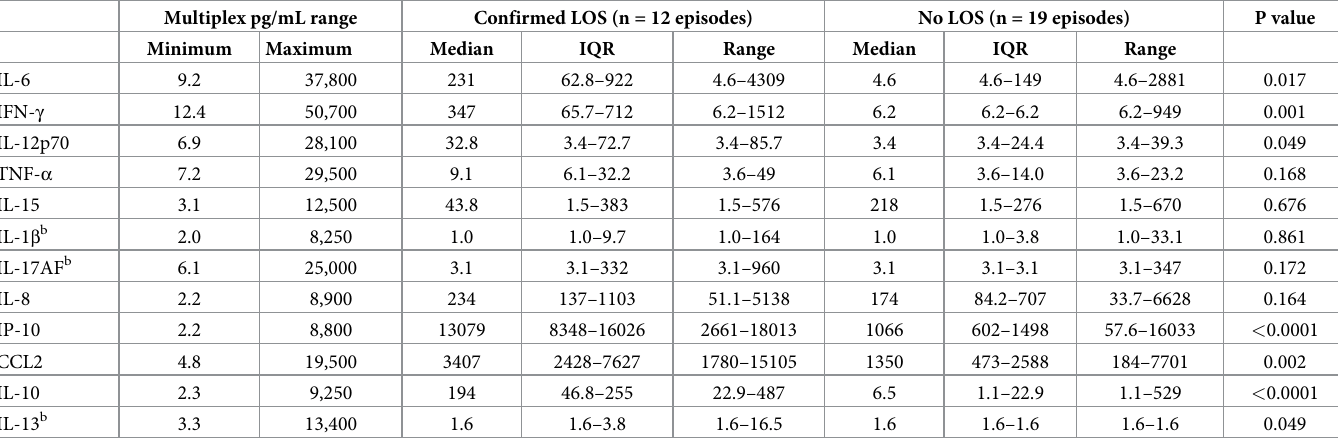
Table 3. Circulating cytokine concentrations at the time of late-onset sepsis evaluation a . Multiplex pg/mL